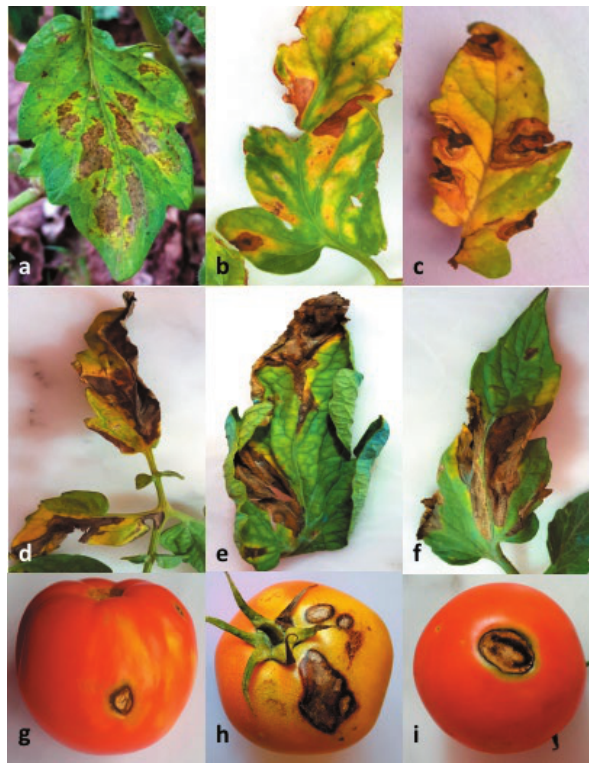
Figure 1. Symptoms caused by Stemphylium spp . on tomato leaves and field-grown fruit. Developing lesions on tomato leaves ( a and b ). Darkening lesions on a tomato leaflet ( c ). Advanced necroses on tomato leaves ( d , e , and f ). Brown speck on ripe ( g ) and unripe toma- to fruit ( h ). Dead tissues of a tomato fruit, colonized by Stemphylium with black felting corresponding to conidium production ( i